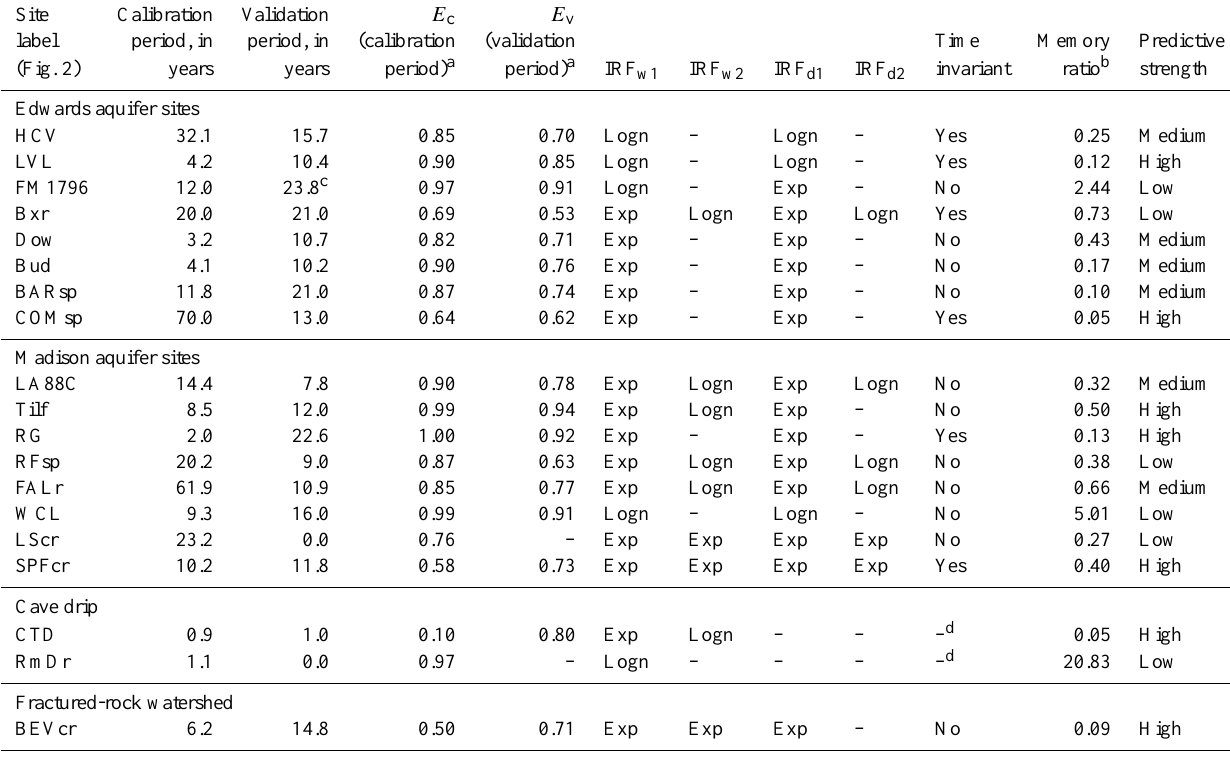
Table 4. Summary of modeling results ( E , coefficient of efficiency; IRF, impulse-response function; w1, wet-period primary; w2, wet-period secondary; d1, dry-period primary; d2, dry-period secondary; Exp, exponential curve; Logn, lognormal curve; –, not